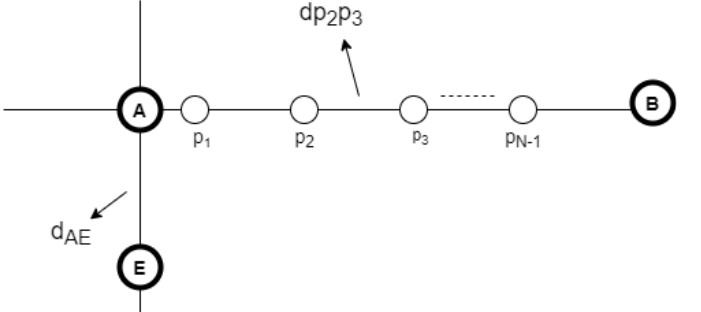
Figure 5. The 2D graph.